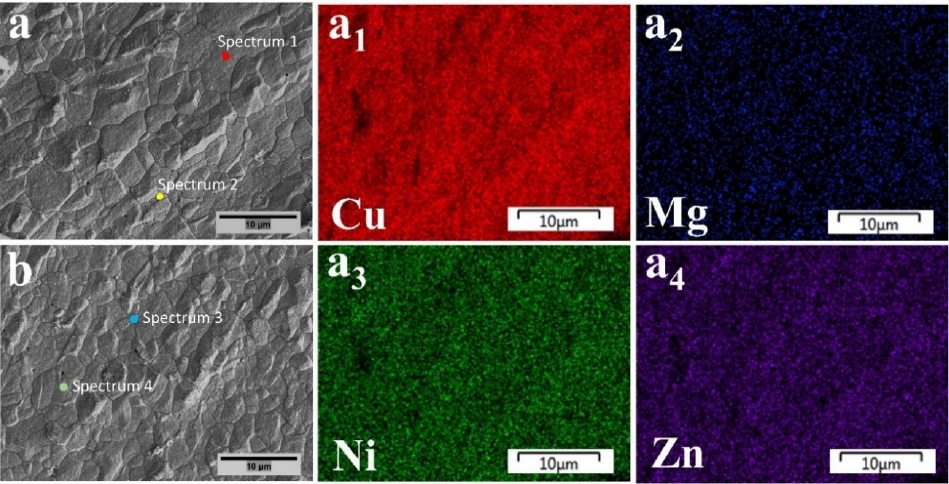
Figure 3. Alloy microstructure and EDS mapping (a,b) SEM of SZ at Accel. Volt. 10 kV, Working Distance 8.90 mm and Magnification 3000x (a 1– a 4 ) EDS mapping for Figure